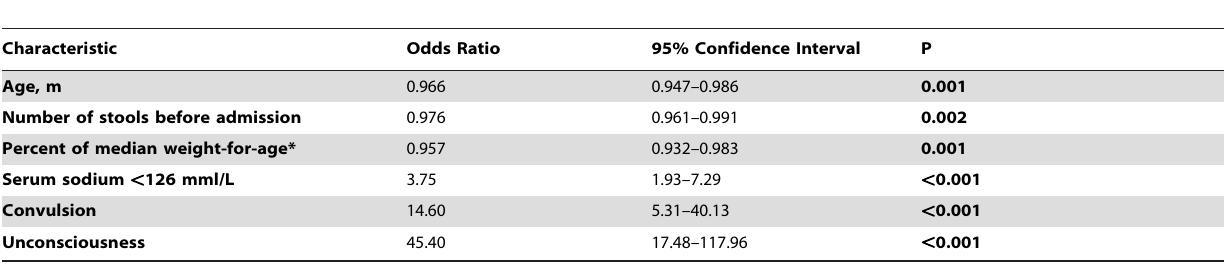
Table 6. Features Predictive of Death in 792 Patients , 15 Years with Shigellosis in a Multiple Logistic Regression Analysis.